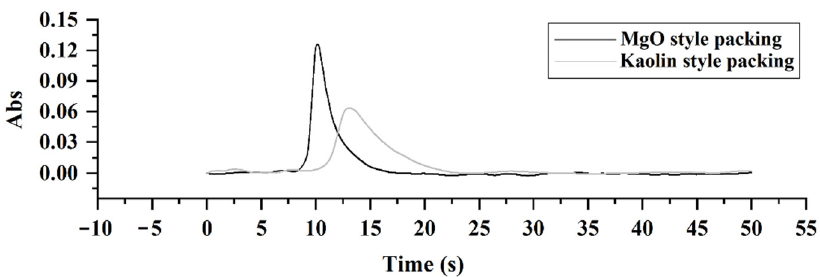
Figure 7. Structural diagram of SS-ETV-AAS instrumentation.